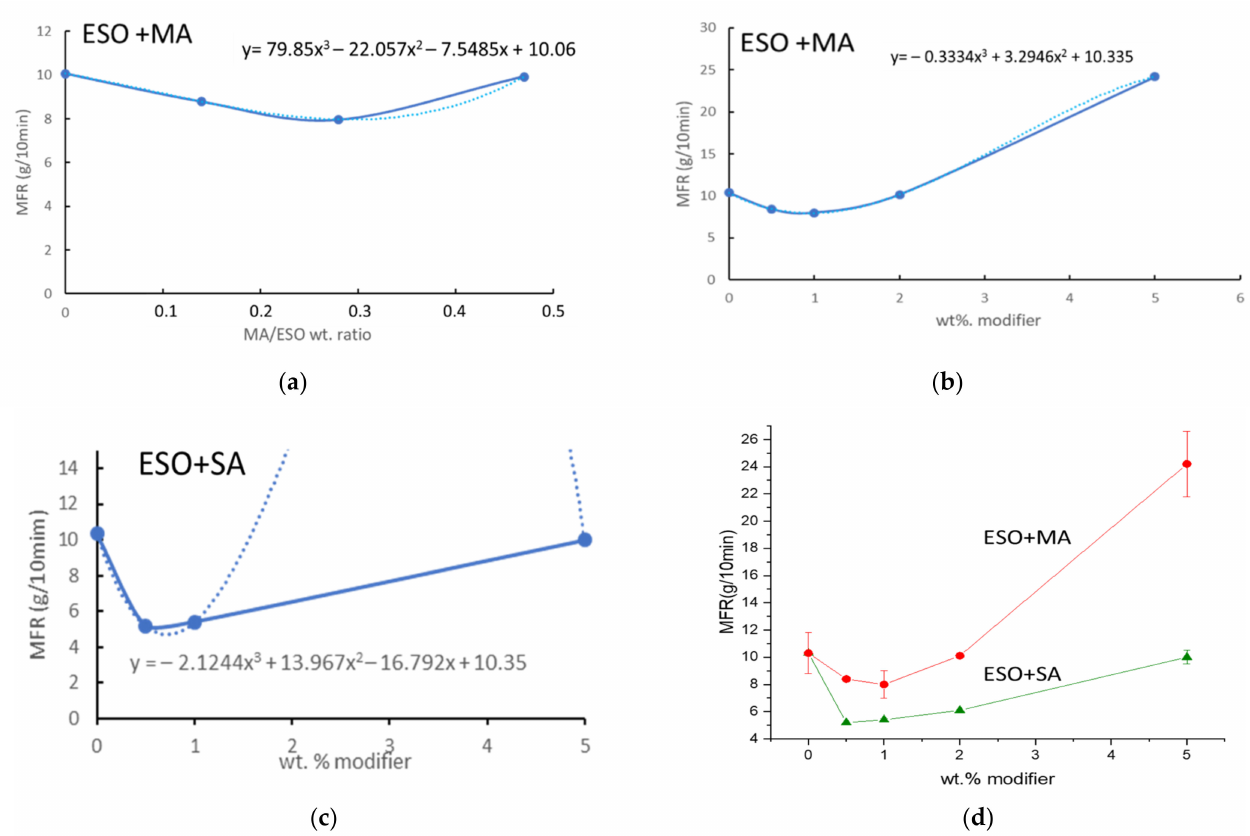
Figure 5. MFR data related to: ( a ) composites with ESO + MA as a function of MA/ESO weight ratio; ( b ) composites with ESO + MA as a function of modifier (ESO + MA, stoichiometric ratio) weight ratio; ( c ) composites with ESO + SA as a function of modifier (ESO + SA, stoichiometric ratio) weight ratio; ( d ) superposition of the trends reported in ( b , c ).